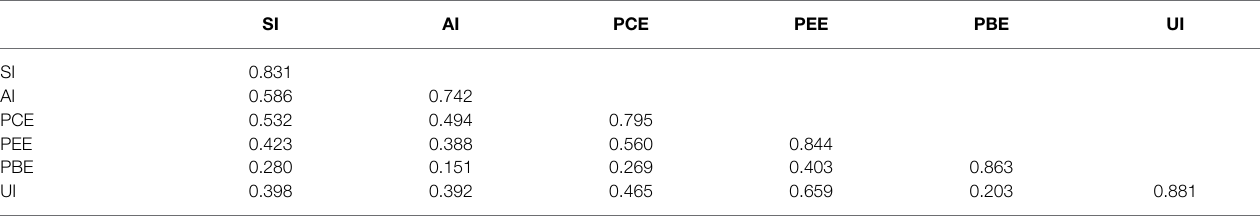
TABLE 4 | Correlation coefficient matrix and square roots of the